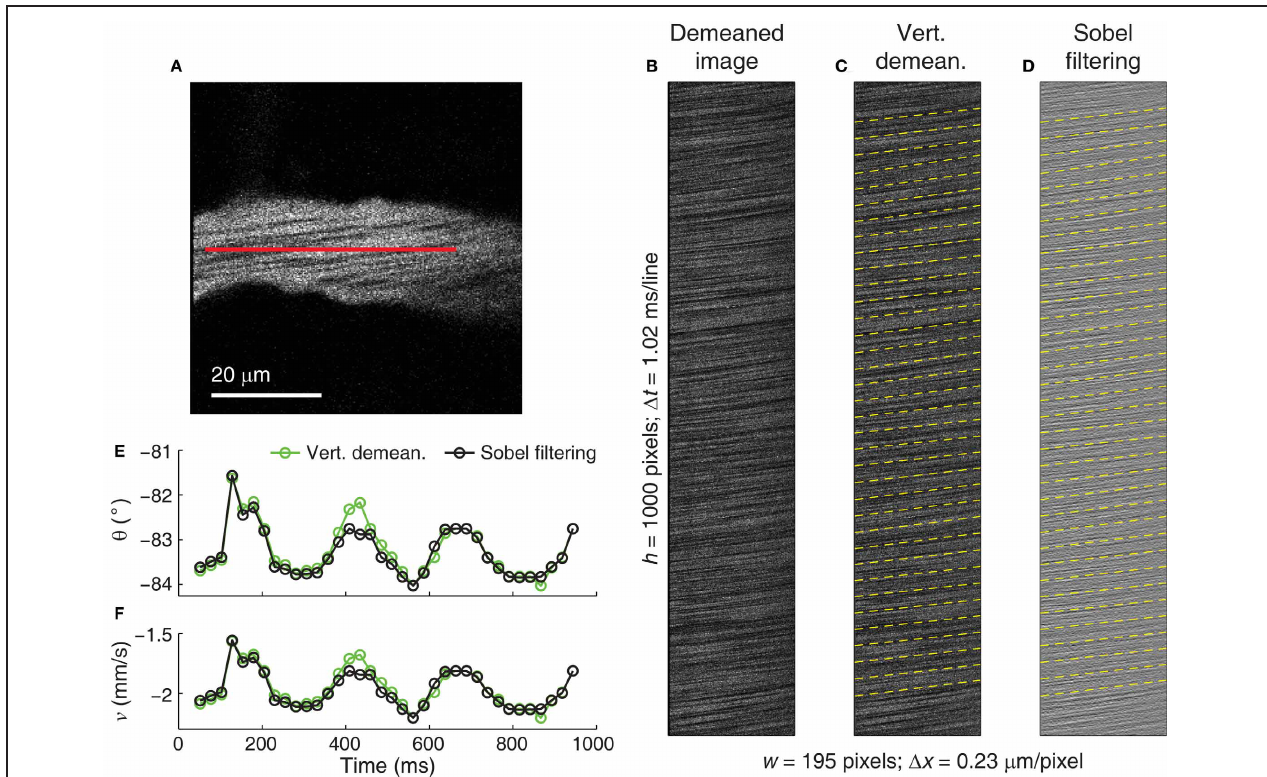
yellow lines represent measured angles over image segments of 100 lines. (E,F) Angle (E) and velocity (F) traces after vertical demeaning (green traces) and Sobel filtering (black traces). Circles represent the dashed lines shown in (C) and (D) . Subtle difference in the values is the result of different filtering (also see Figure 8 ). δ of ∼ 0.0055 ◦ was used in order to achieve (cid:2) v / v of < 0.1% (see Equation 17) on the overlapping image segments of 100 lines which offered δ n of < 0.001 ◦ (see Equations